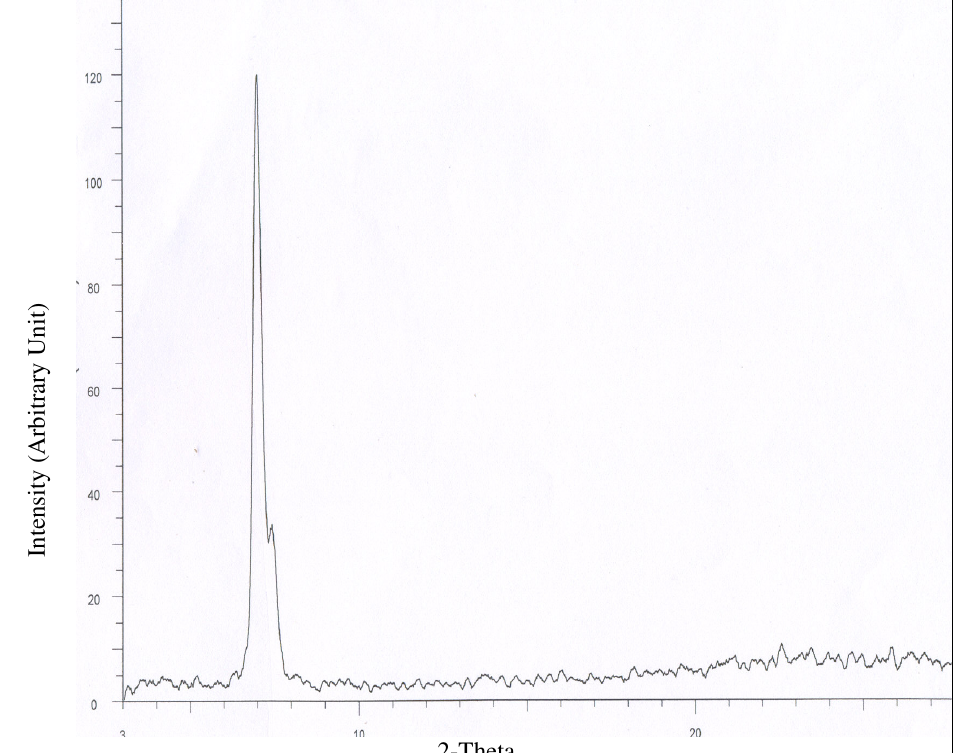
Figure 4. X-ray diffractogram of NiPc thin film prepared at substrate temperature